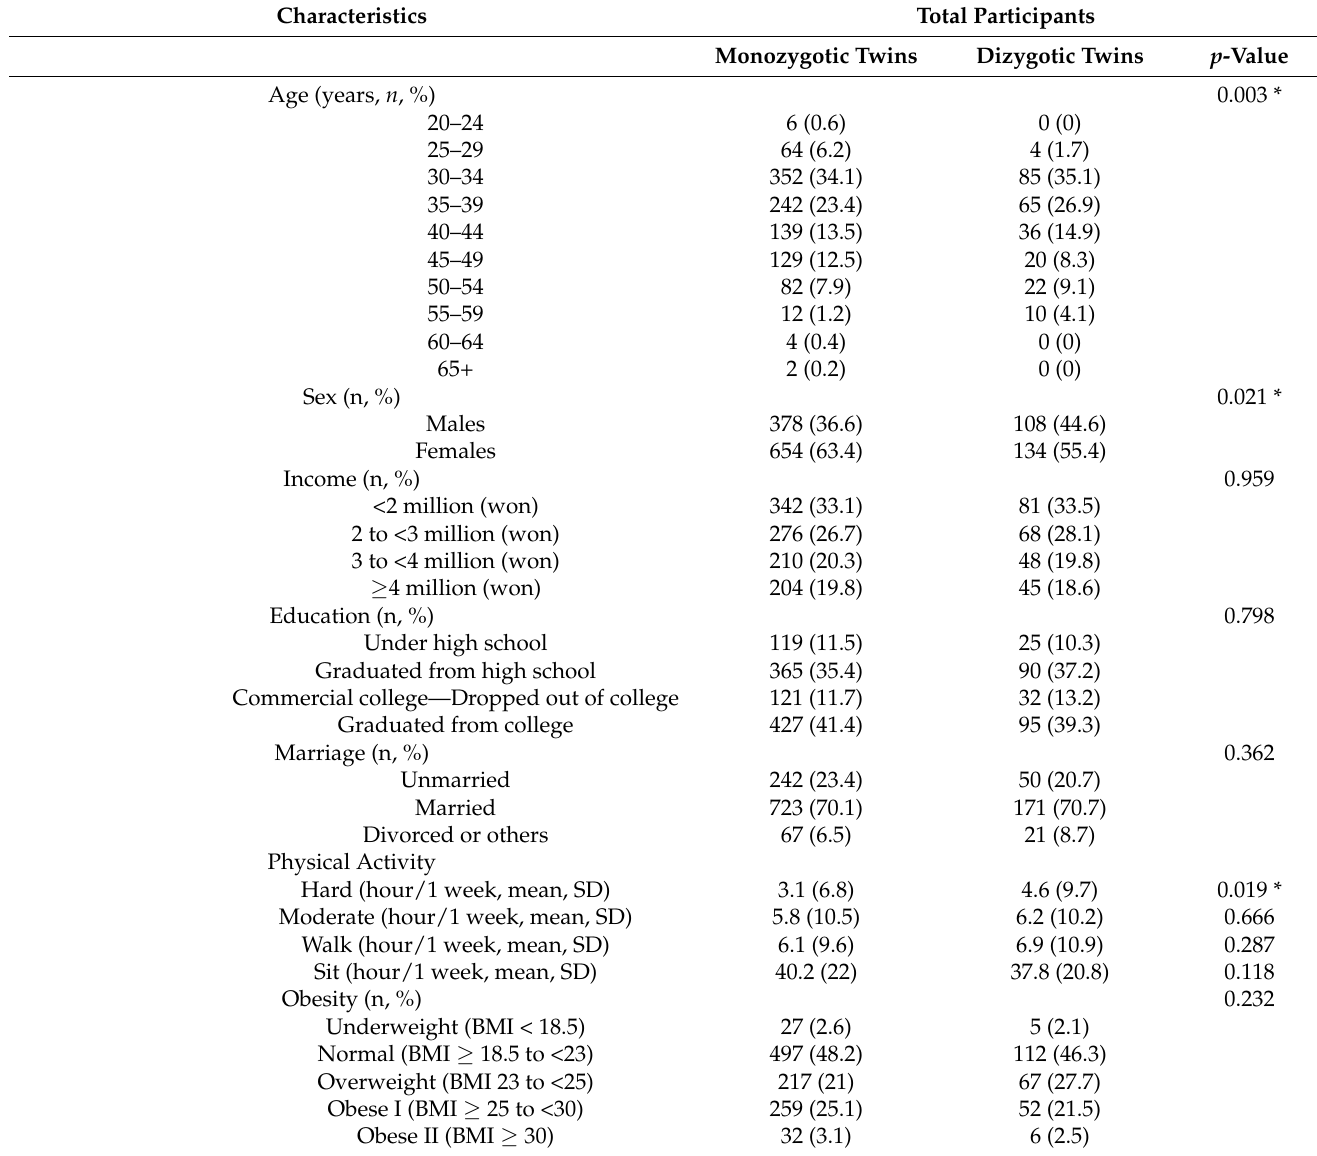
Table 1. Baseline features of the monozygotic and dizygotic